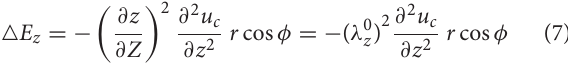
Comparing this equation with Equation (3) yields that the